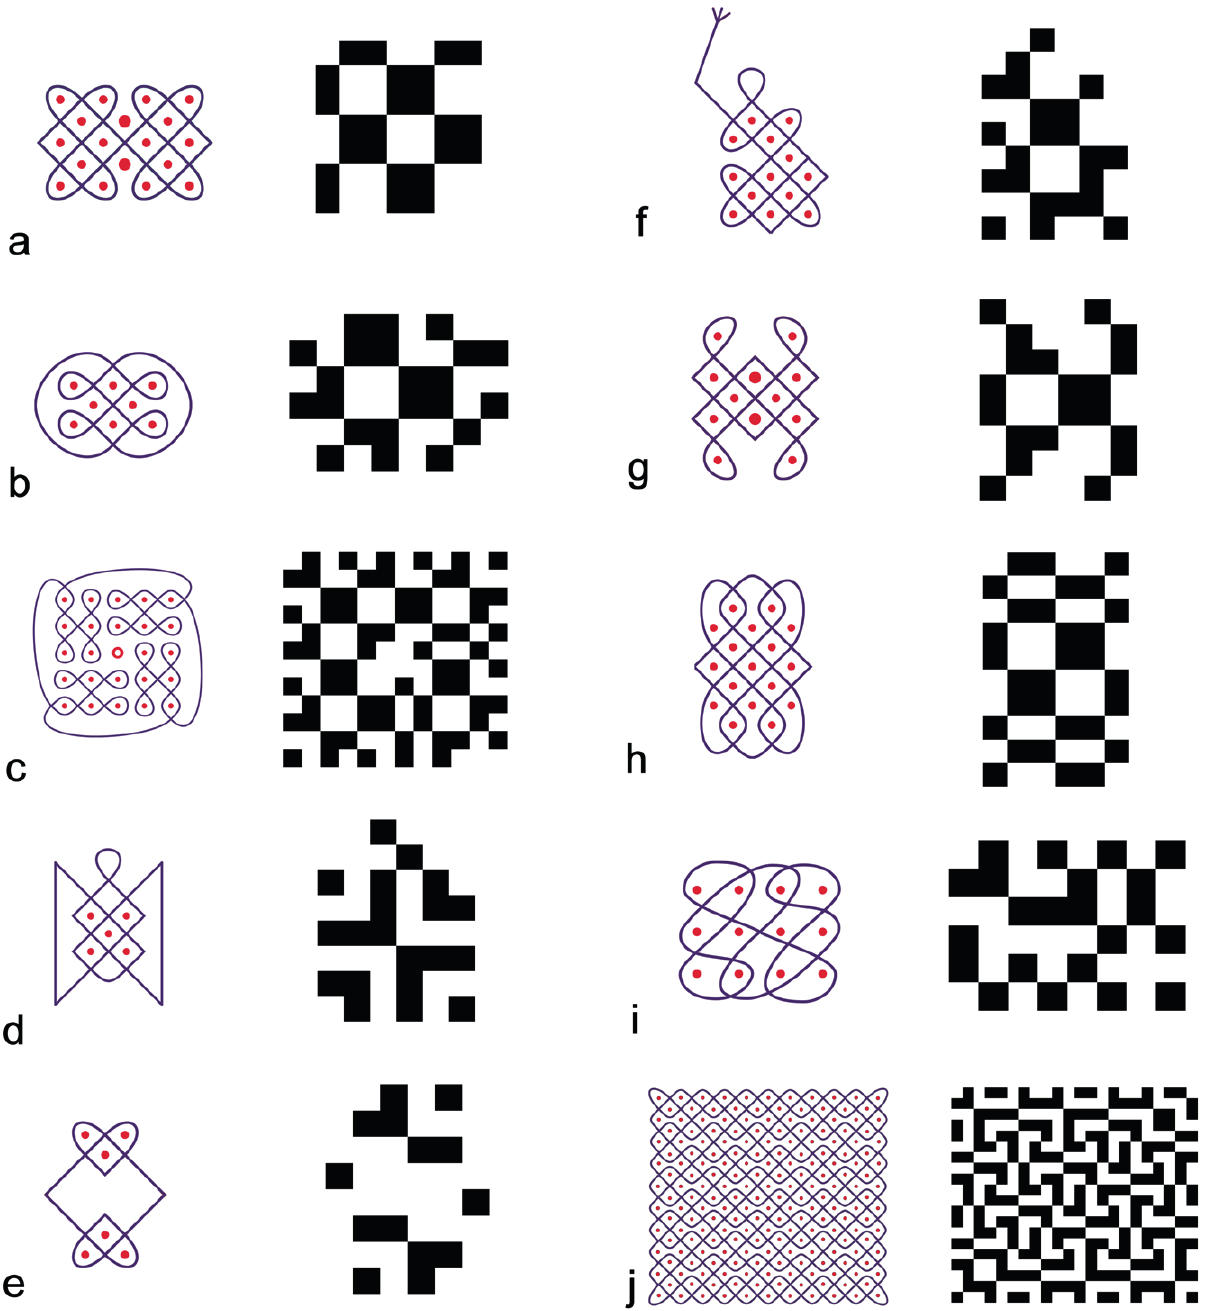
Figure 6. All of the Tchokwe sona ideograms and their corresponding checkerboard patterns used in this study: (a) a nest of doves, (b) an antelope’s paws, (c) walking on tiptoes in a forest, (d) a fairy swallow (a.k.a. a wading bird or a stork), (e) a bridge made of sticks and lianas, (f) a human being, (g) the story about a bat and the sun, (h), fire, (i) looking sick, and (j) inside the belly of a